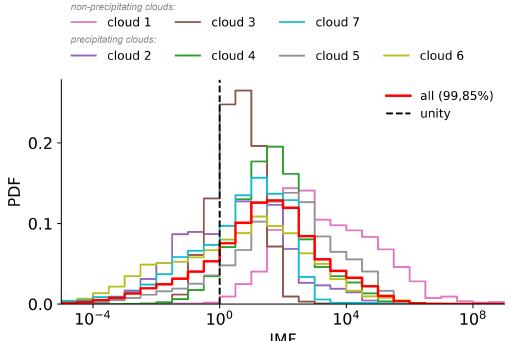
Figure D1. Probability density functions (PDFs) of obtained ice multiplication factors (IMFs, Eq. 12) for each of the seven observed clouds and all IMFs combined (thick solid red) using all ice crystal number concentration data (not only above cloud base). The dashed black line indicates unity. The median IMF and the percentage of IMF larger than unity for the combined histogram are given in the